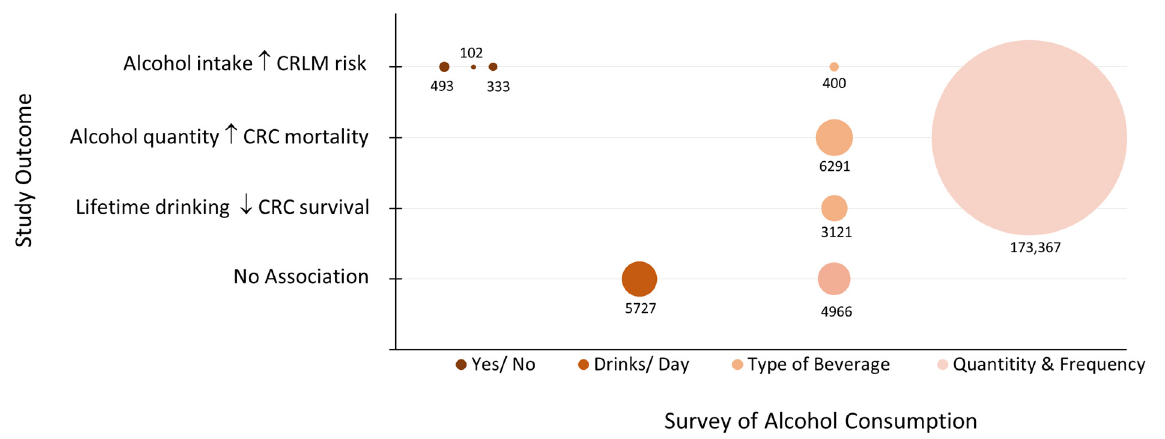
Figure 3 . Bubble plot of clinical studies by outcome and survey of alcohol intake. The size of the bubble is proportional to the study sample size as noted. CRC: colorectal cancer; CRLM: colorectal liver metastasis.